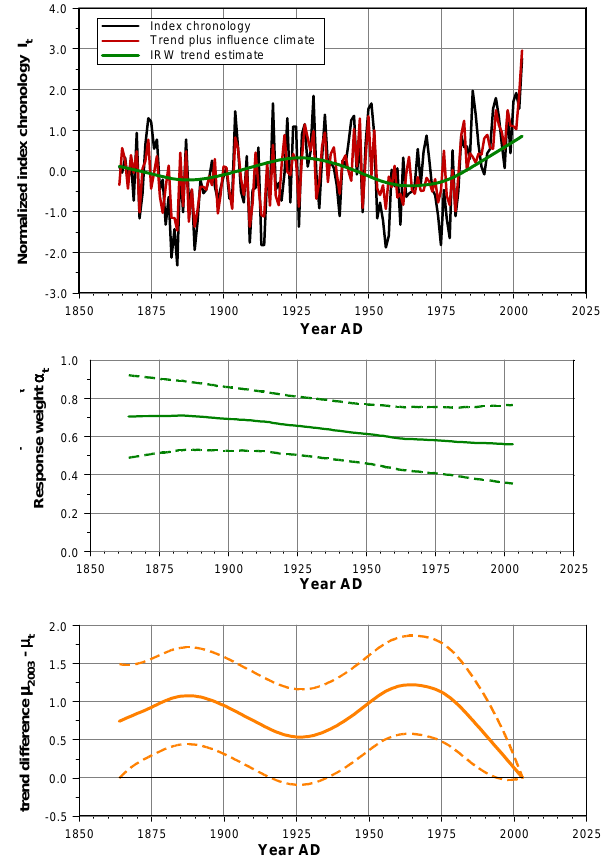
Fig. 3. SRF estimates for Larch, standardized by RCS (first chronology in Table 2). Period: 1864-2003. The upper graph shows the index chronology (black line), the IRW trend (green line) and the trend plus climate influence (red line). The middle panel shows time-varying response ˆ α t and the lower panel the trend differences [ ˆ µ 2003 − ˆ µ t ]. The dashed lines represent 95% confidence limits.